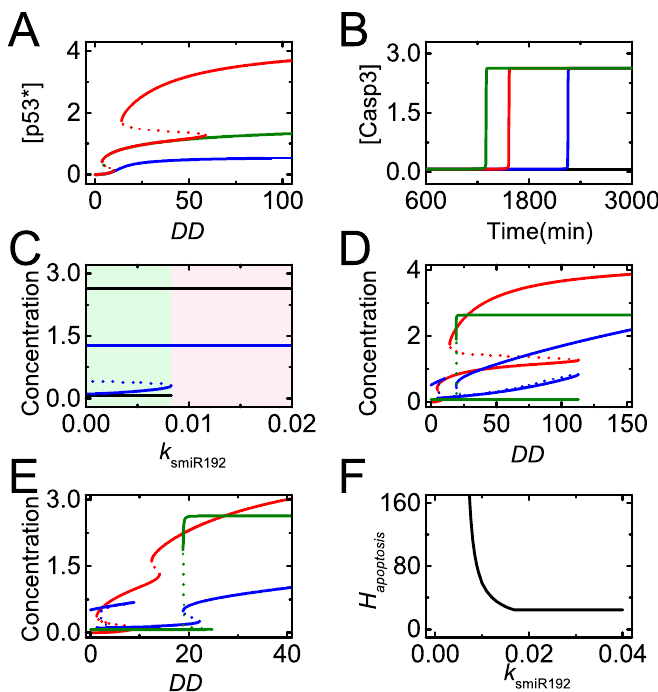
Figure 9. The induction of miR-192 is required for apoptosis induction. ( A ) Bifurcation diagram of [p53 ∗ ] versus DD for k smiR192 = 0, k spten = 0 or 0.06 (blue, the lines for the two cases are overlapped), k smiR192 = 0.01, k spten = 0 (green), and k smiR192 = 0.01, k spten = 0.06 (red); ( B ) time courses of [Casp3] with k smiR192 = 0.02 (dark green), 0.01 (red, the default case), 0.0085 (blue) and 0.006 (black) at DD = 100; ( C ) bifurcation diagrams of [miR-22] (blue) and [Casp3] (black) versus k smiR192 with DD = 100. Here, k smiR192 varies from 0 to twice the default value. For relatively small k smiR192 , cells will undergo cell cycle arrest (light green region), while for rather large k smiR192 , cells will undergo apoptosis (light pink region). ( D , E ) Bifurcation diagrams of [p53 ∗ ], [E2F1] and [Casp3] versus DD with k smiR192 = 0.008 ( D ) and 0.03 ( E ); ( F ) the curve of H apoptosis versus k smiR192